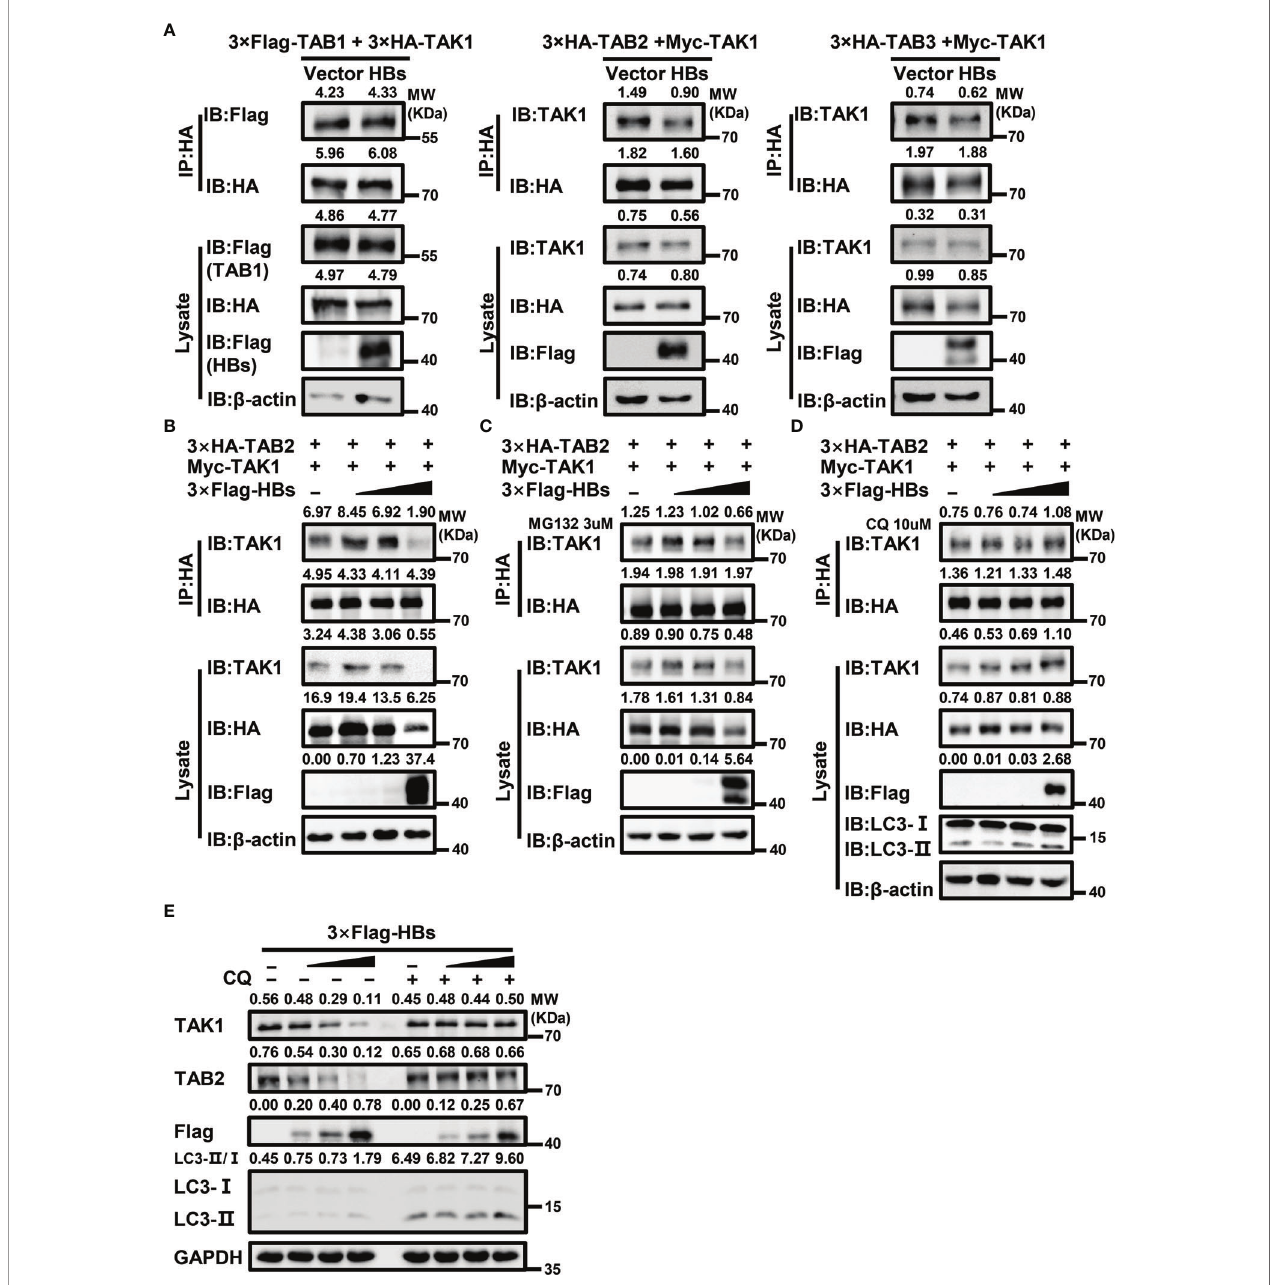
FIGURE 5 | HBsAg suppresses TAK1-TAB2 interaction through autophagic degradation. (A) HBs expression plasmids (3×Flag-HBsAg) or vector plasmids were co- transfected into human embryonic kidney (HEK293T) cells with indicated plasmids for 48 h, and then cells were harvested for Co-IP and western blot assays using indicated antibodies. (B, C, D) CQ, but not MG132, reversed the suppression effect of HBsAg on the interaction between TAK1 and TAB2. HEK293T cells were co- transfected with 3×HA-TAB2 (3 m g), Myc-TAK1 (3 m g) and increasing amounts (0, 0.12, 0.6, 3 m g) of 3×Flag-HBs (HBsAg), the total amount of plasmids was adjusted to 10 m g with empty vector. At 24 h post co-transfection, cells were serum starved for 12 h and treated without (B) or with MG132 (3 m M) (C) /CQ (10 m M) (D) for 24 h, then harvested for Co-IP and western blot assays with indicated antibodies. (E) HBsAg facilitated the degradation of TAK1 and TAB2 in a dose- dependent manner in HepG2 cells, and the effect disappeared with the treatment of CQ. Increasing amount of 3×Flag-HBs (0, 0.35, 1, 3 m g) were transfected into HepG2 cells for 24 h. The total amount of plasmids was adjusted to 3 m g. Next cells were treated with or without CQ (10 m M) for 24 h, and then harvested for Co-IP and western blot